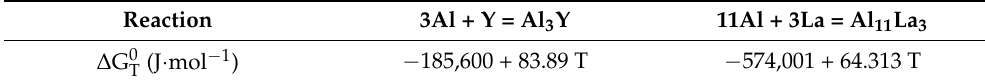
Table 4. Gibbs free energy of Al 3 Y and Al 11 La 3